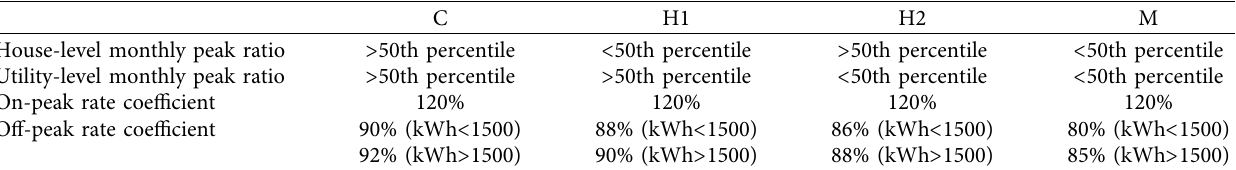
Table 1: Customer